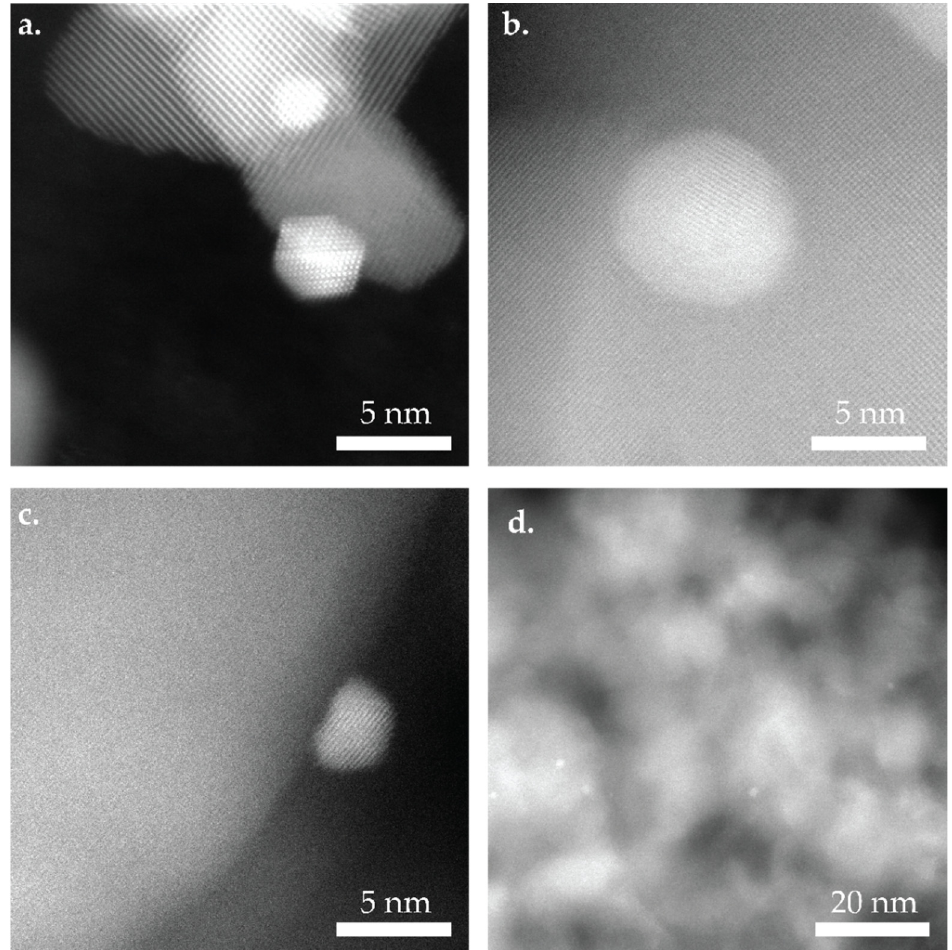
Figure 1. Representative High-Angle Annular Dark-Field Scanning Transmission Electron Microscopy micrographs of gold nanoparticles supported on oxidic supports. ( a ) Au/CeO 2 , ( b ) Au/WO 3 , ( c ) Au/TiO 2 , ( d ) Au/SiO 2 .